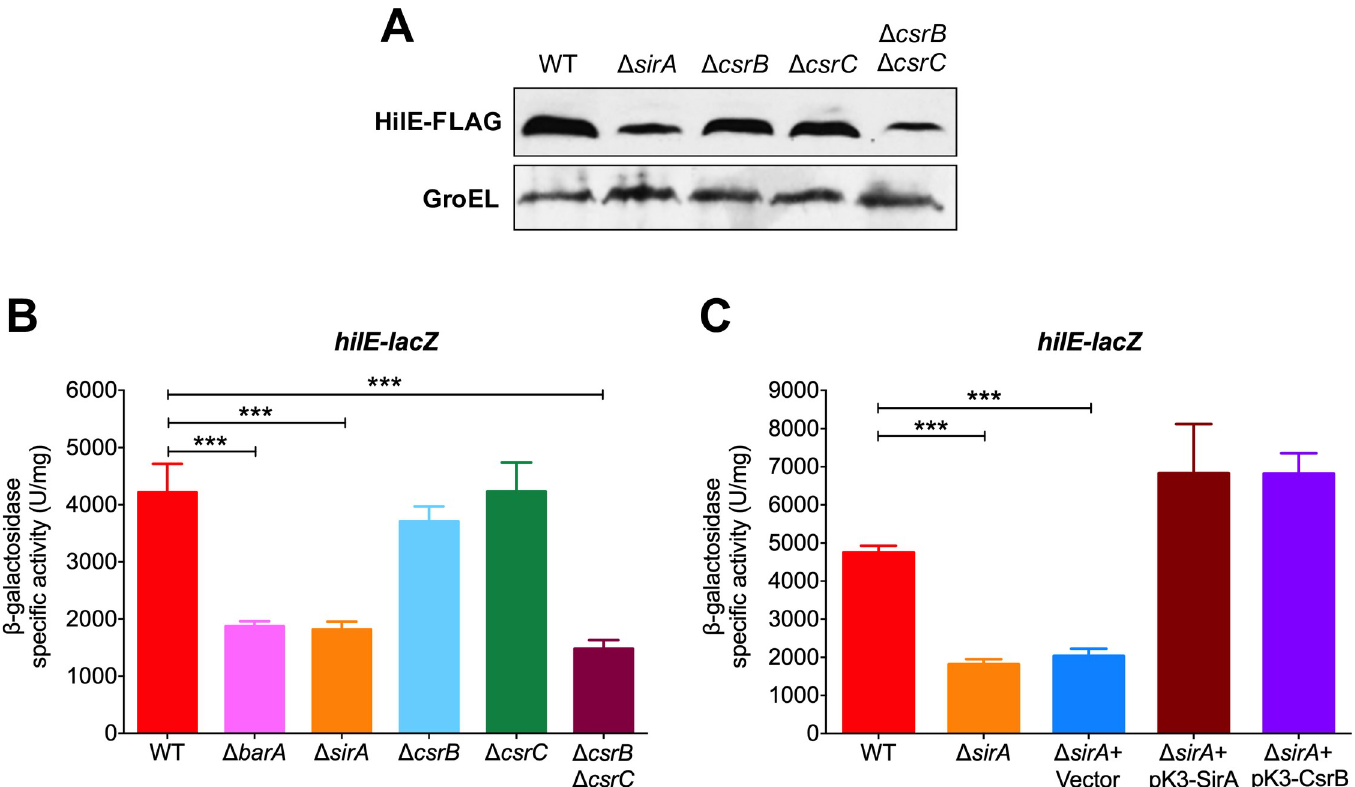
Fig 3. SirA/BarA and CsrB/CsrC positively regulate the expression of hilE . (A) Western blot analysis of HilE-FLAG expression in the WT S . Typhimurium strain and its derivative Δ sirA , Δ csrB , Δ csrC and Δ csrB Δ csrC mutants carrying a chromosomal FLAG-tagged hilE gene, using monoclonal anti-FLAG antibodies. As a protein loading control, the expression of GroEL was also determined using polyclonal anti-GroEL antibodies. (B) β -galactosidase activity of the translational hilE-lacZ fusion contained in the philE-lacZ plasmid was determined in the WT S . Typhimurium strain and its derivative Δ barA , Δ sirA , Δ csrB , Δ csrC and Δ csrB Δ csrC mutants. (C) β -galactosidase activity of the translational hilE-lacZ fusion contained in the philE-lacZ plasmid was determined in the WT S . Typhimurium strain and its derivative Δ sirA mutant in the absence or presence of pMPM-K3 vector, pK3-SirA or pK3-CsrB plasmids, which express SirA and CsrB, respectively, from a constitutive promoter. Data represent the average of three independent experiments done in duplicate. Error bars symbolize the standard deviations. Statistically different values are indicated ( ��� , p - value < 0.0001). Western blot and β -galactosidase assays were performed with samples taken from bacterial cultures grown in LB at 37˚C.